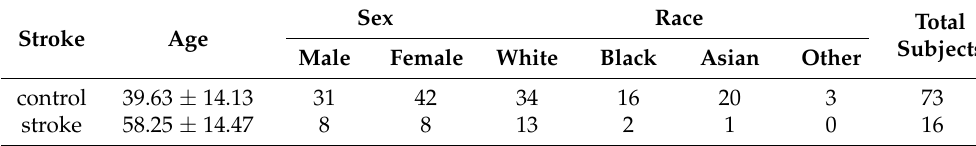
Table 1. Demographics for full